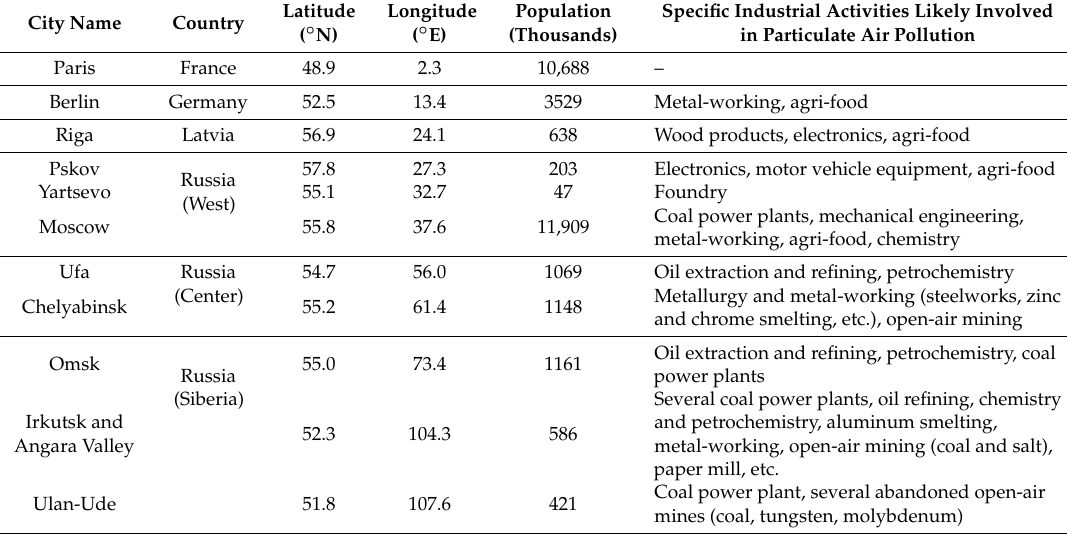
Table 1. List of the 11 cities included in this study along with their geographic coordinates and 2013 population [45]. Specific industrial activities that are likely to influence the aerosol composition are also mentioned, if any. Power plant data come from Davis et al. [46]; location of oil and gas wells in Russia are provided by Ulmishek